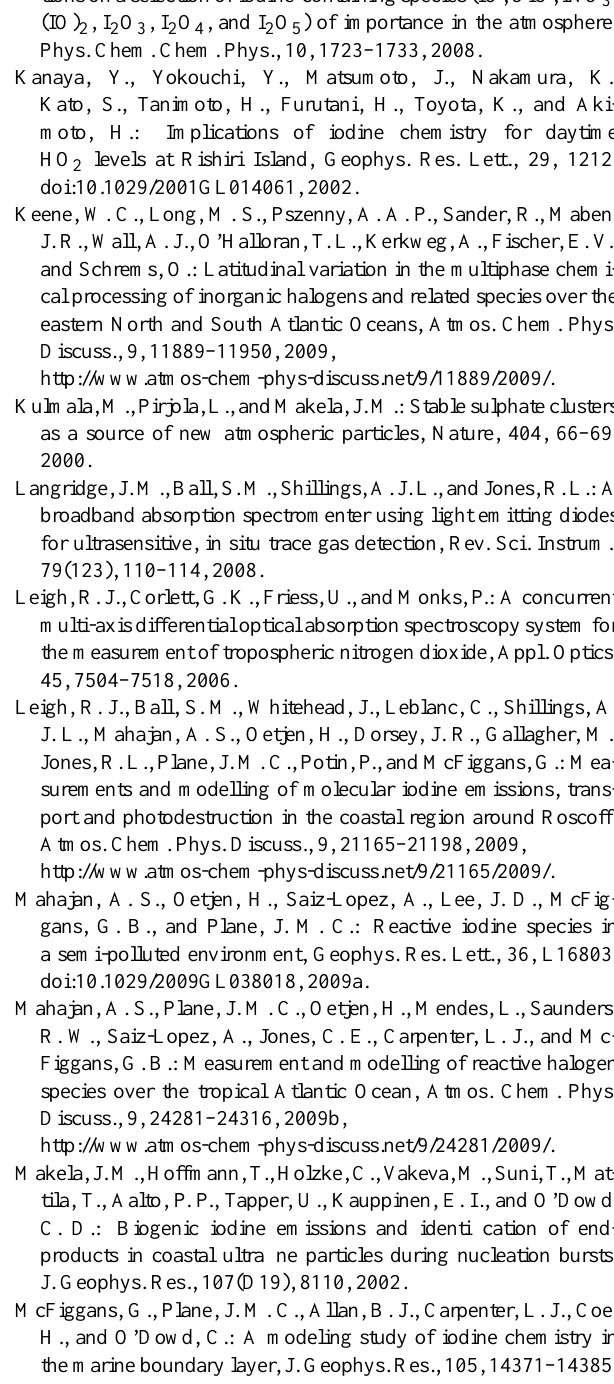
Figgans, G. B.: Measurement and modelling of reactive halogen species over the tropical Atlantic Ocean, Atmos. Chem.